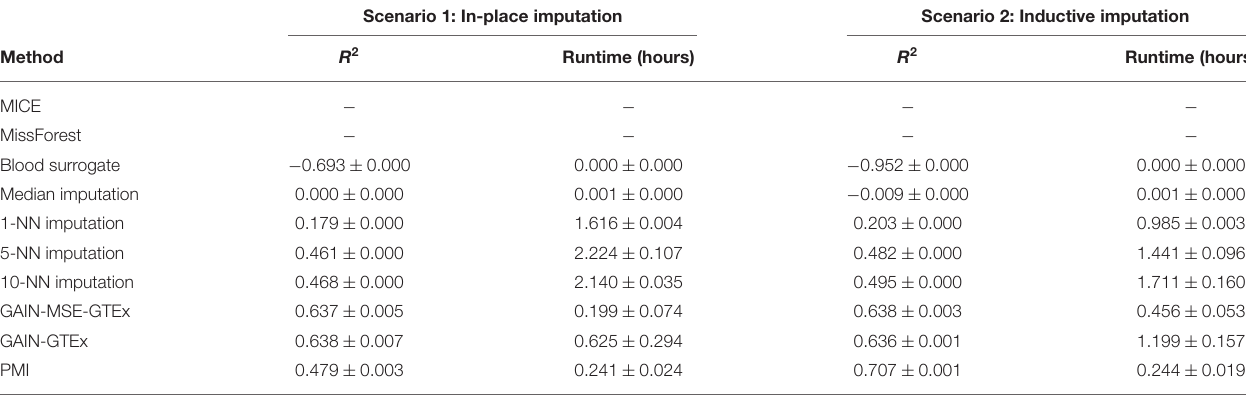
TABLE 1 | Gene expression imputation performance with a missing rate of 50% across 3 runs (complete set of protein-coding genes). Scenario 1: In-place